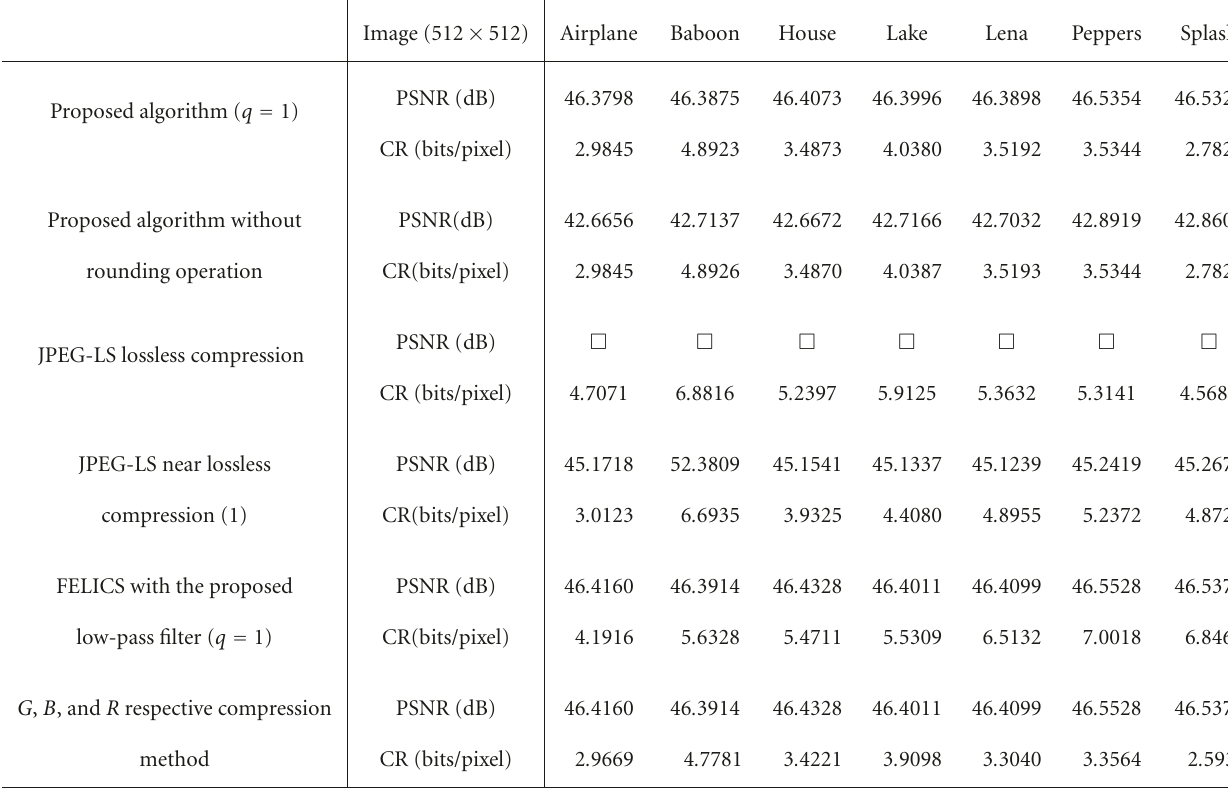
Table 3: Compression results for test image. CR means compression rate and (cid:2) means